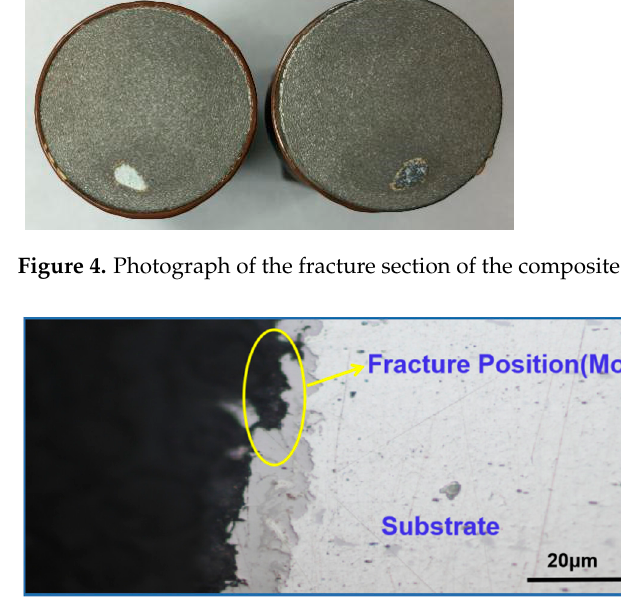
Figure 5. Cross-sectional metallographic image of the fracture section of the composite coating.